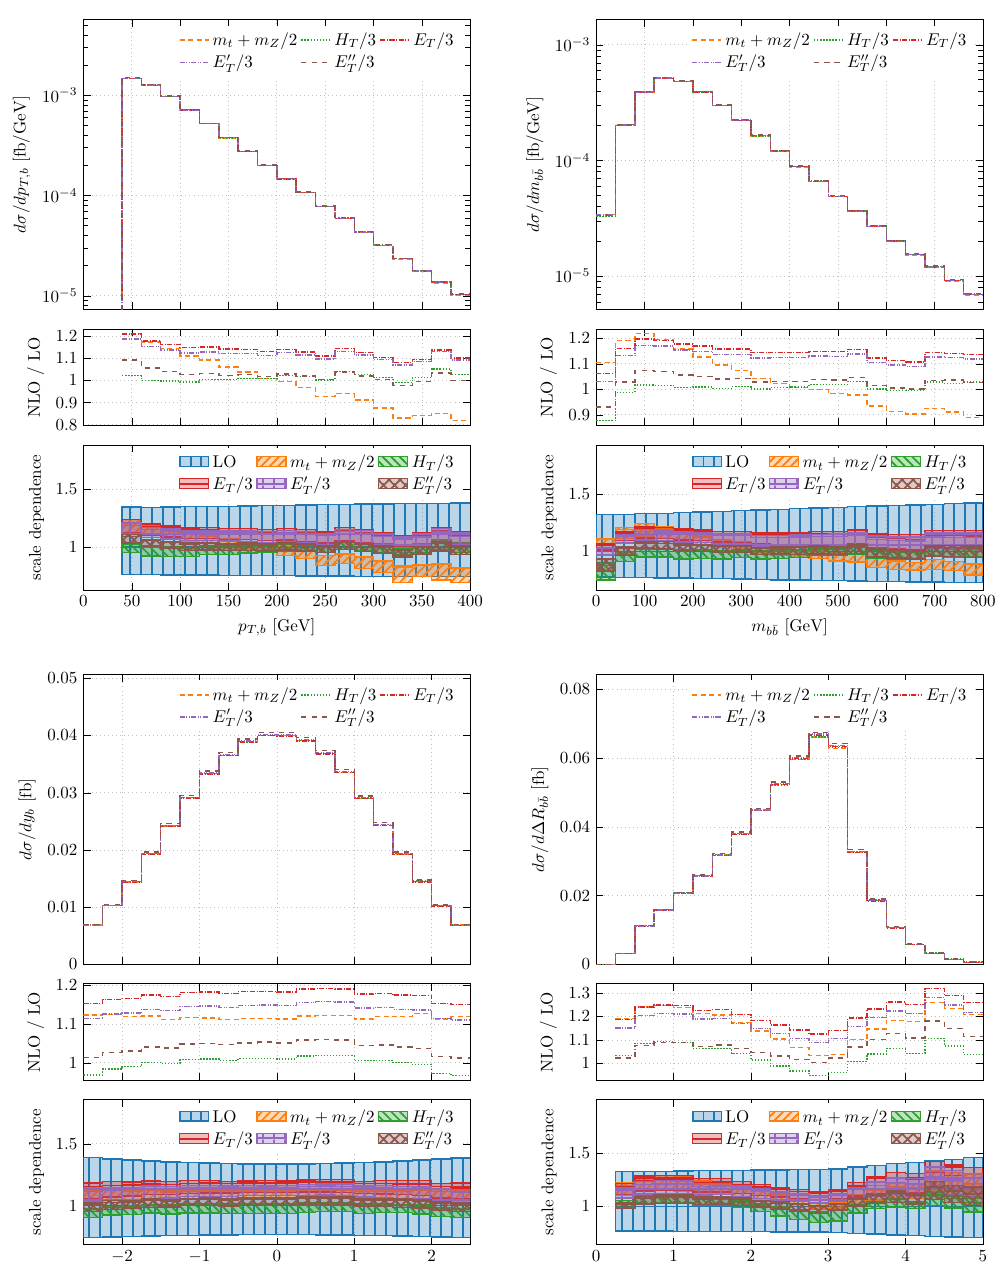
Figure 6 . The pp e + (cid:23) e (cid:22) (cid:0) (cid:22) (cid:23) (cid:22) b (cid:22) b (cid:23) (cid:28) (cid:22) (cid:23) (cid:28) + X di(cid:11)erential cross section distribution as a function of ! (averaged) p T;b , m , (averaged) y b and (cid:1) R at the LHC run II with p s = 13 TeV. The upper b (cid:22) b b (cid:22) b plots show absolute NLO QCD predictions for various values of (cid:22) 0 where (cid:22) R = (cid:22) F = (cid:22) 0 . The middle panels display di(cid:11)erential factors. The lower panels present di(cid:11)erential factors together K K with the uncertainty band from the scale variation for various values of (cid:22) 0 . Also given is the relative scale uncertainties of the LO cross section for (cid:22) 0 = m t + m Z = 2. The LO and the NLO CT14 PDF sets are employed.